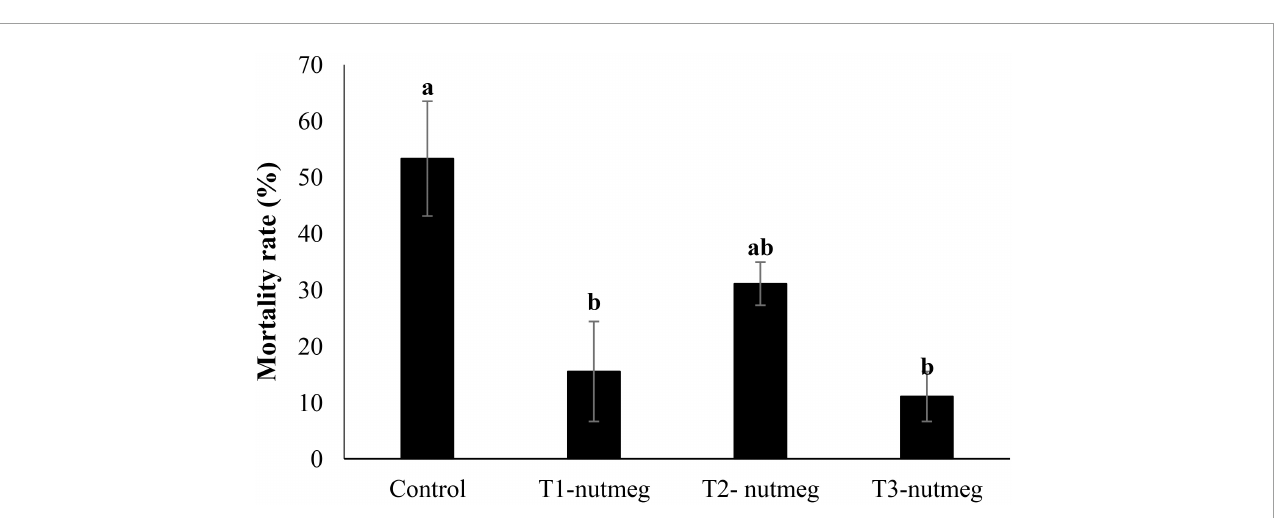
FIGURE3 The mortality rate of zebrafish fed the experimental diets and exposed to the cold-water challenge (13 ± 2 ◦ C) (mean ± S.D.). Bars assigned with different small letters denote significant differences among treatments ( P <